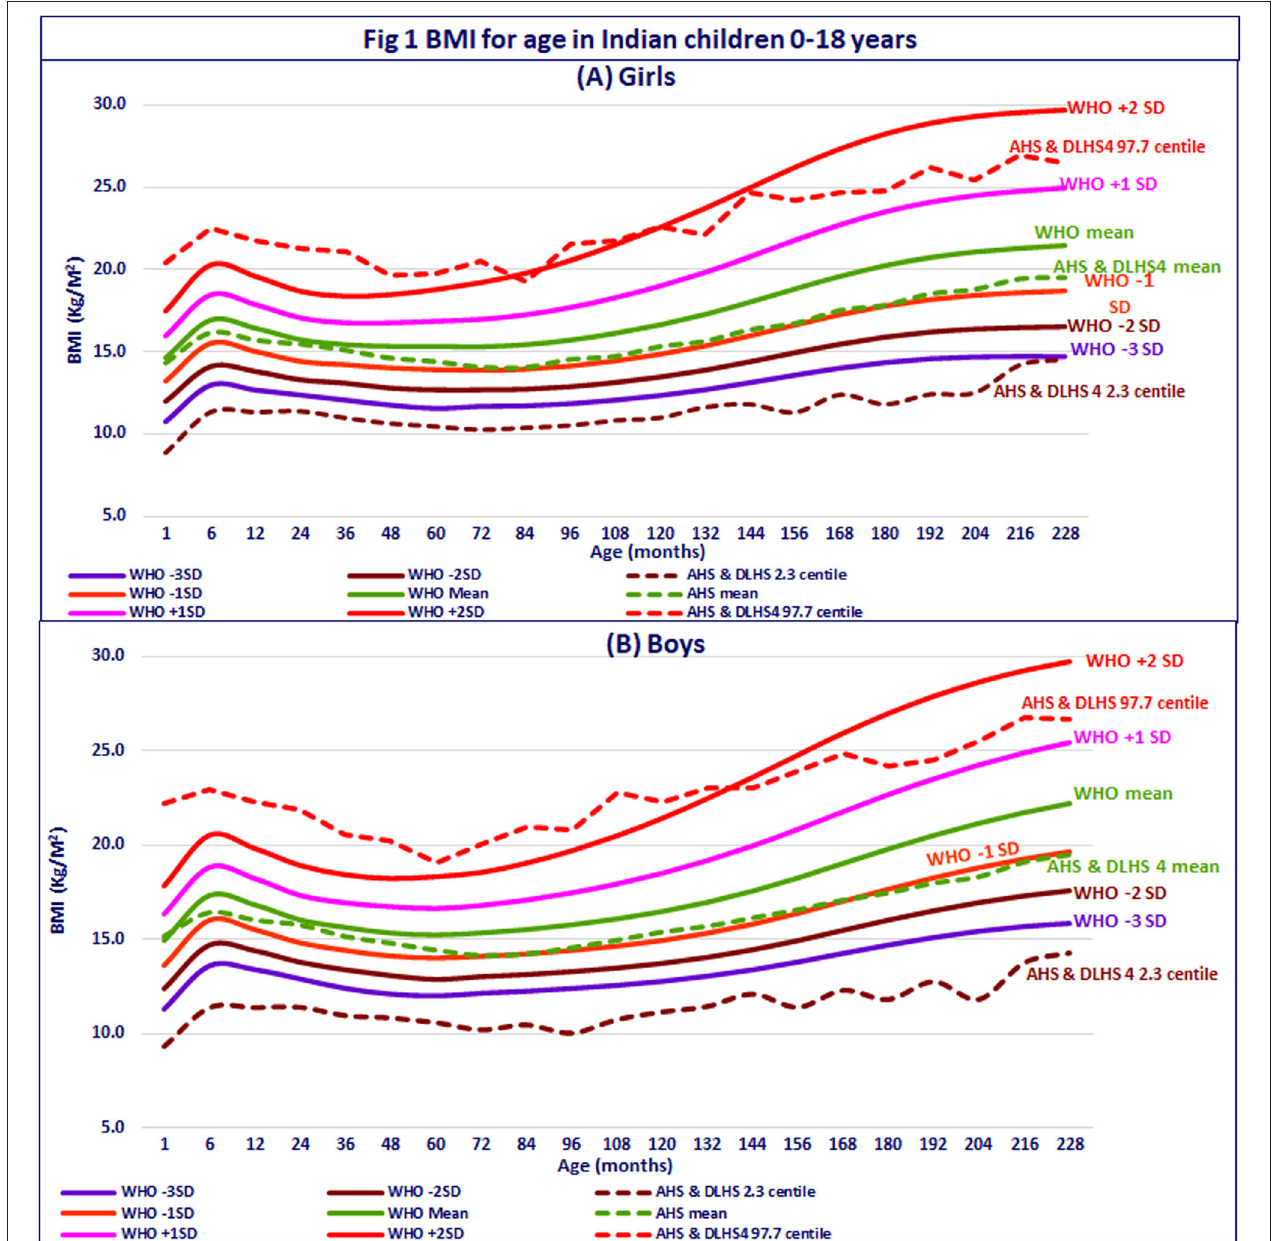
FIGURE 1 | BMI for age in Indian children 0–18 years. (A) Girls. (B) Boys.